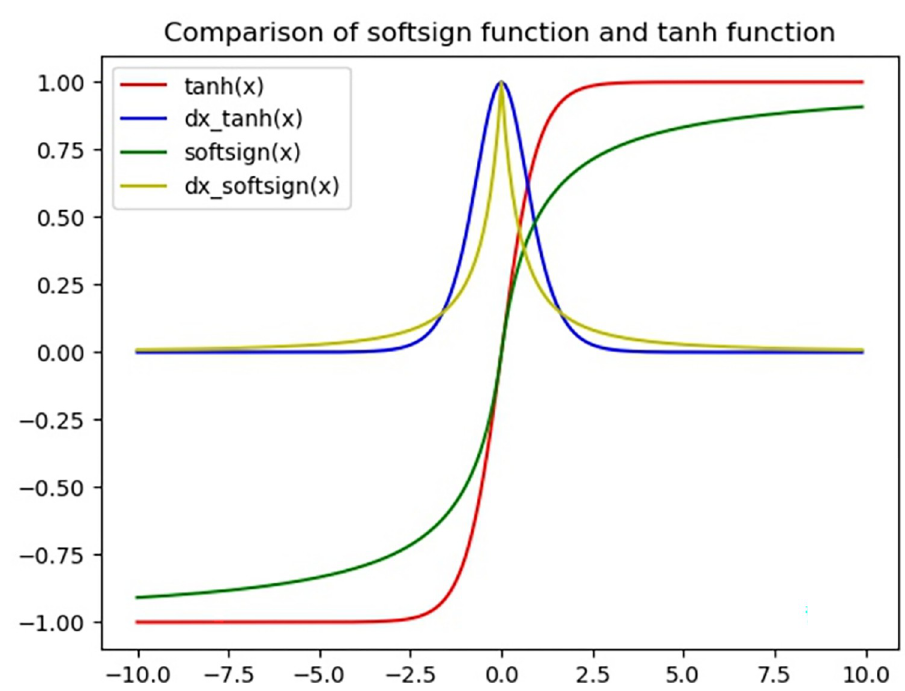
Fig 3. Comparison of softsign function and tanh function. A red line represents tanh , a blue line represents derivative of tanh , a green line represents softsign , and a yellow line represents derivative of softsign .